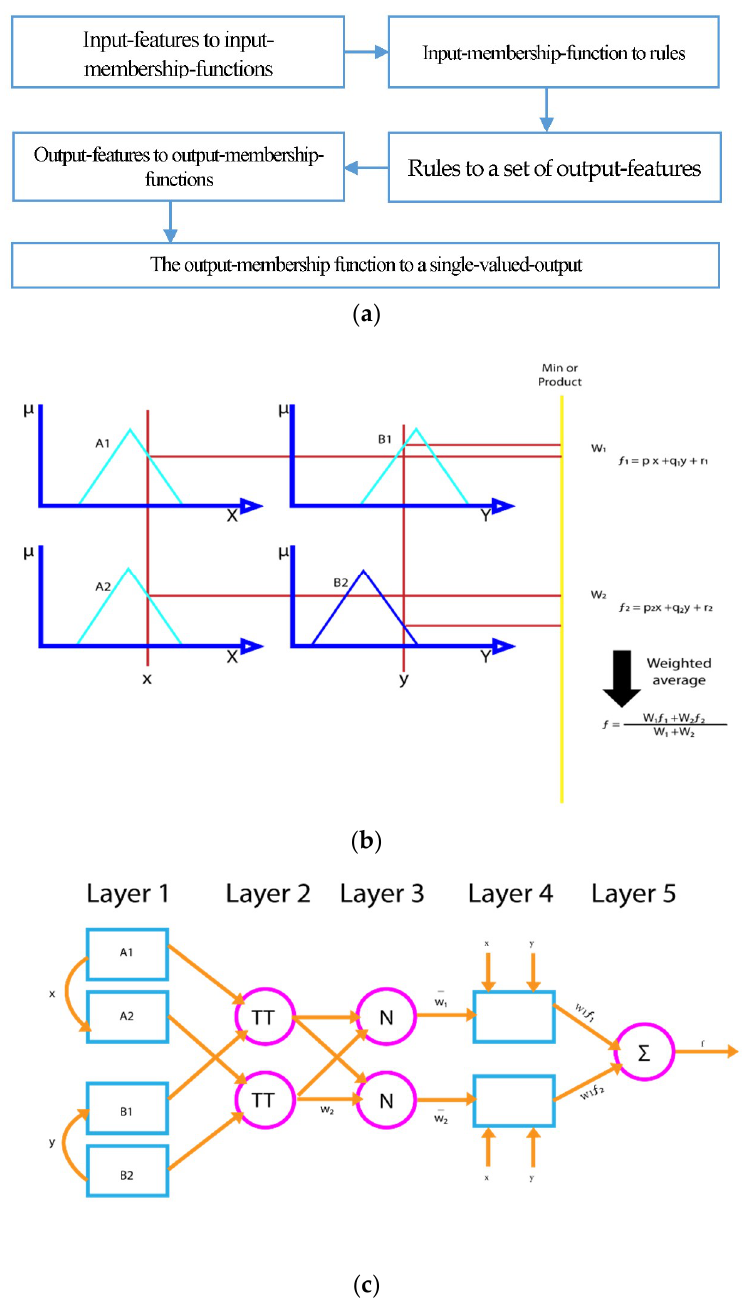
Figure 6. Adaptive neuro fuzzy inference system: ( a ) five functional blocks in ANFIS; ( b ) two-input first-order Sugeno fuzzy model with two rules; and ( c ) equivalent ANFIS structure.